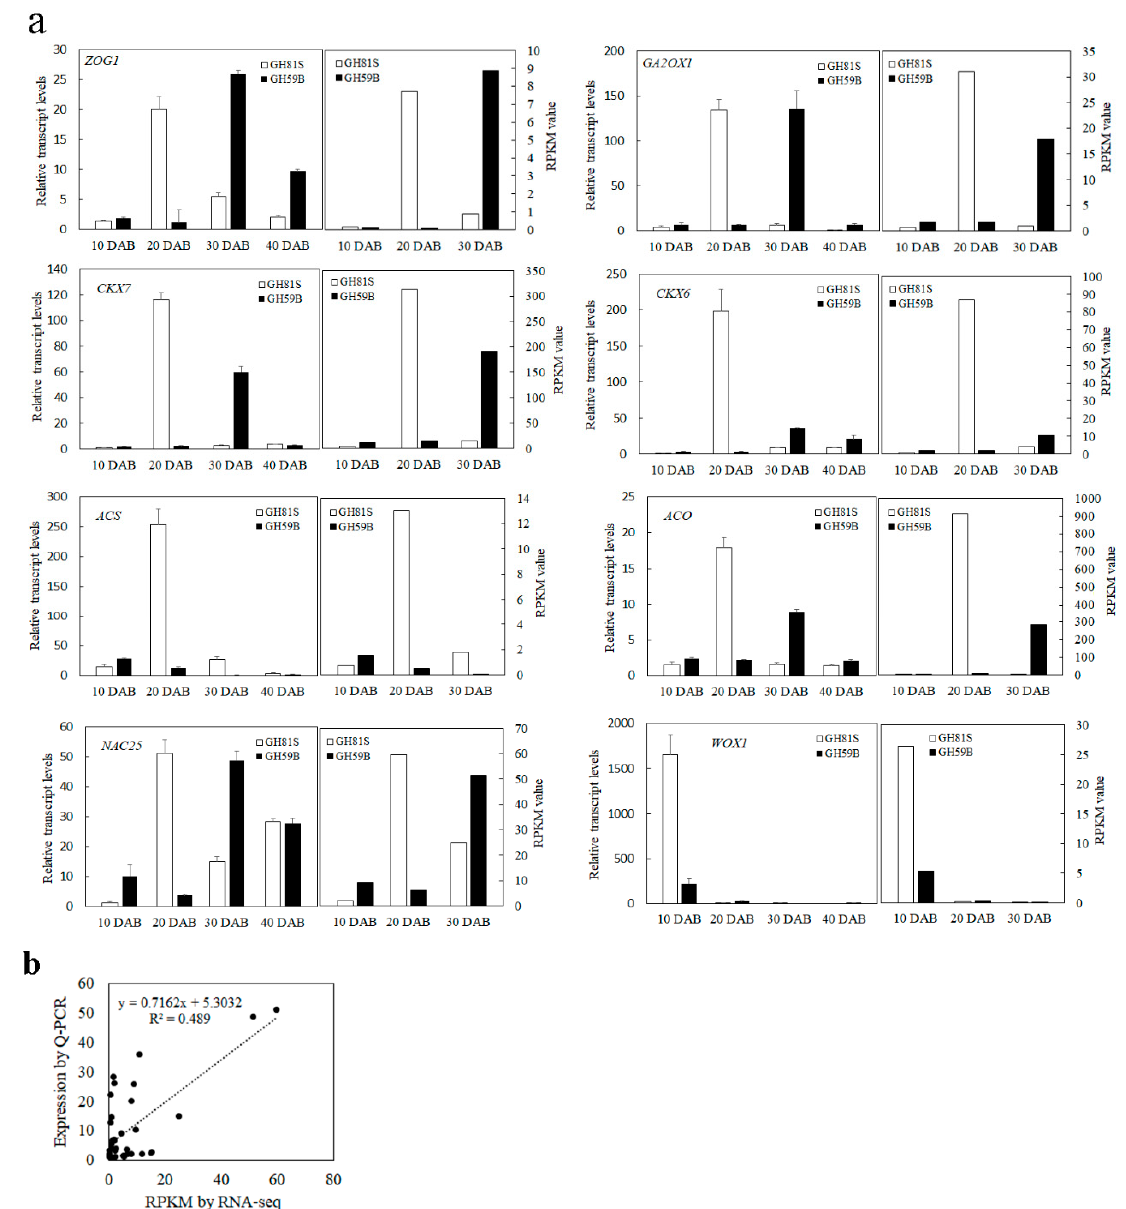
Figure 4. The expression of eight genes in fruit of ‘GH81S’ and ‘GH59B.’ ( a ) Q-PCR validation of differential gene expression. ( b ) Coefficient analysis between the gene expression ratios obtained from RNA-seq and Q-PCR data.